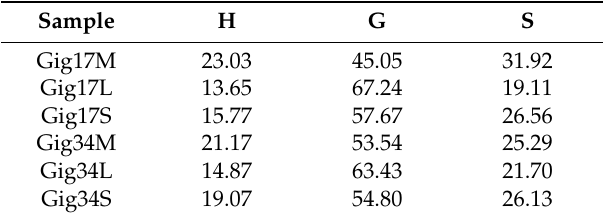
Table 9. Ratio of the monomer units (H, G, S) in lignins obtained from M. x giganteus . Stem/leaf mixtures (Gig17M, Gig34M), stems (Gig17S, Gig34S), and leaves (Gig17L, Gig34L).